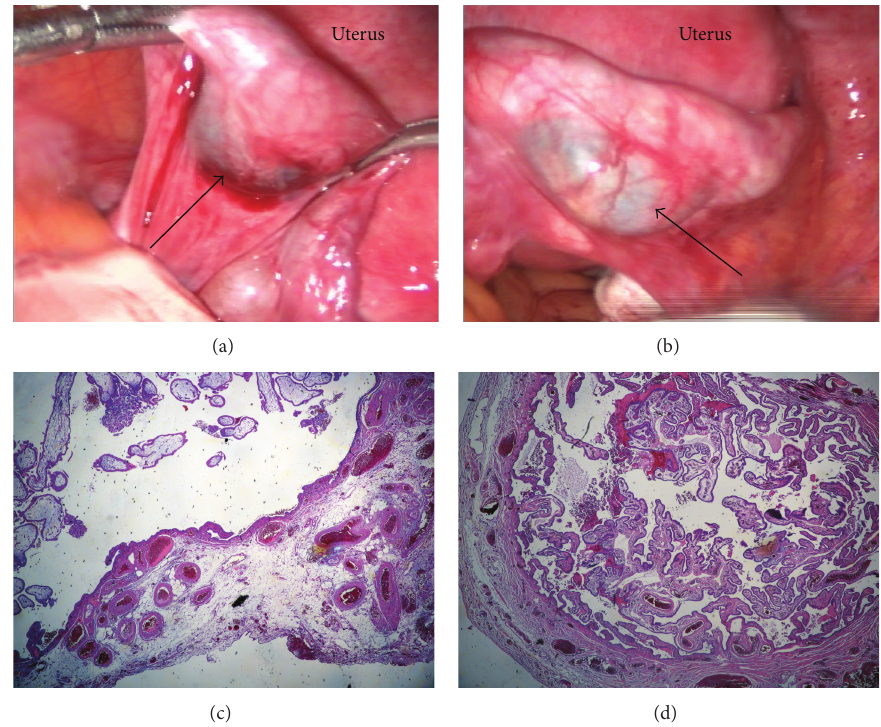
Figure 1: (a) Laparoscopic view of the left Fallopian tube, containing the ectopic pregnancy (arrow). (b) Laparoscopic view of the right Fallopian tube, presenting a congestive dilatation mimicking an ectopic pregnancy (arrow). (c) Histological section of the left Fallopian tube which is distended and contains many chorionic villi (upper left part of the image), confirming extrauterine tubal pregnancy (hematoxylin and eosin stain; original magnification 25x). (d) Histological section of the right Fallopian tube which is distended by an oedematous mucosa with congestive blood vessels, with no chorionic villi (hematoxylin and eosin stain; original magnification